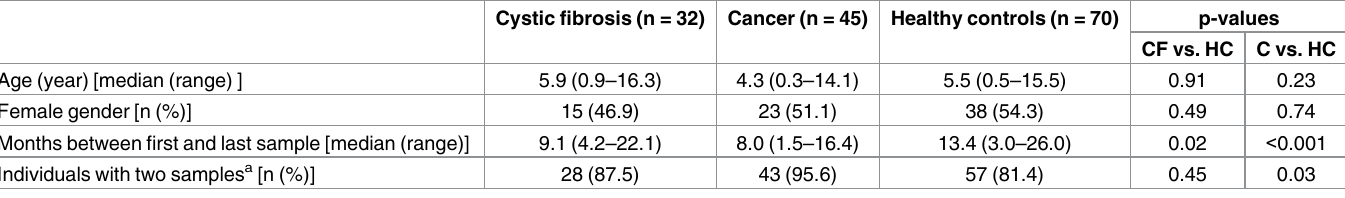
Table 1. Background information and faecal sample information on the children with cystic fibrosis, the children with cancer and the healthy children.